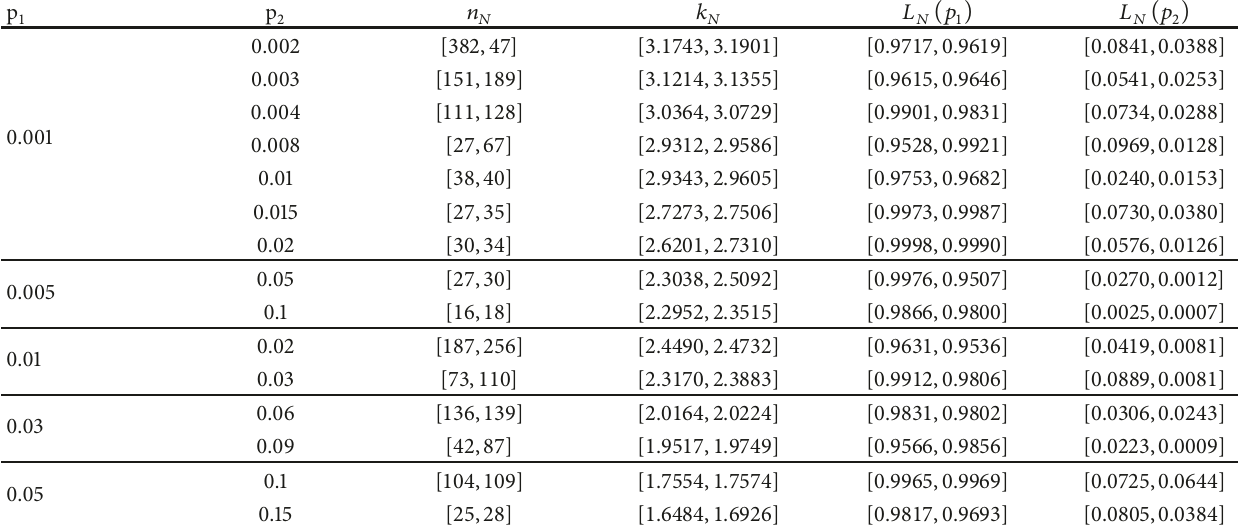
Table 2: The plan parameters when 𝛼 = 0.05 , 𝛽 =0.10, 𝑟